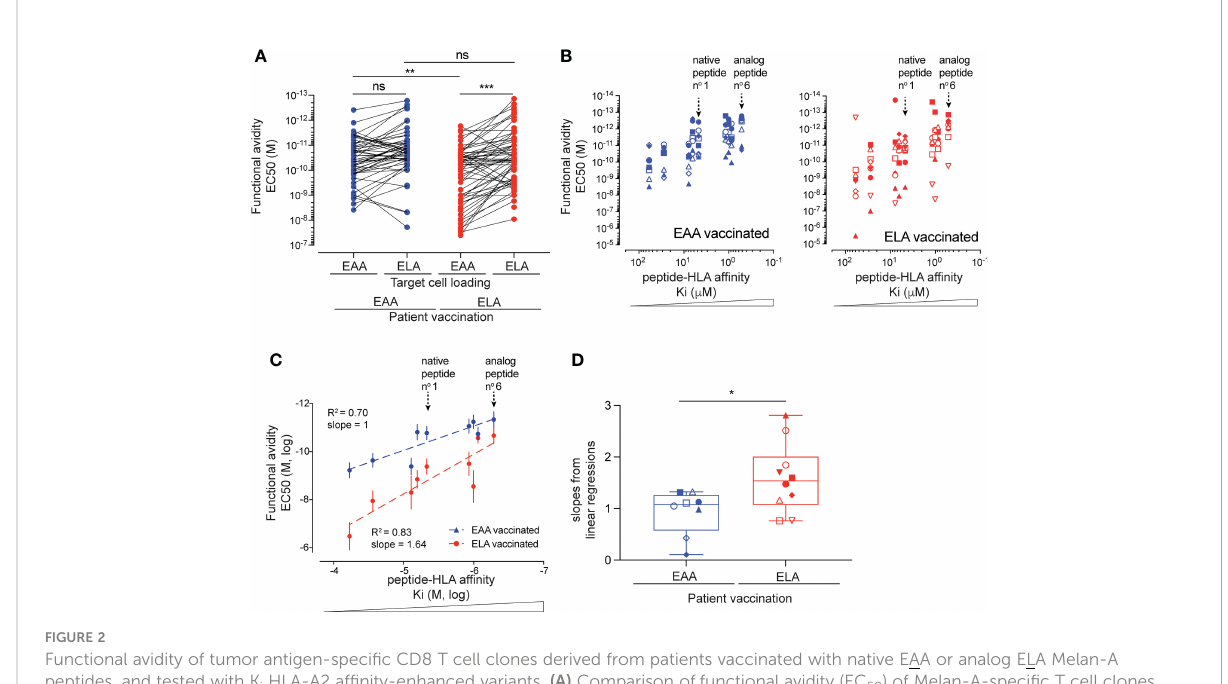
FIGURE 2 Functional avidity of tumor antigen-speci fi c CD8 T cell clones derived from patients vaccinated with native EAA or analog ELA Melan-A peptides, and tested with K i HLA-A2 af fi nity-enhanced variants. (A) Comparison of functional avidity (EC 50 ) of Melan-A-speci fi c T cell clones obtained from patients vaccinated with native EAA (n=31) or analog ELA (n=26) peptide and tested in criss-cross experiments against native (EAA) and analog (ELA)-pulsed targets. (B) Association analysis between functional EC 50 avidity of T cells isolated from EAA (left, n=8) or ELA (n=10) vaccinated patients and K i af fi nity values of the target peptide variants. Symbols represent individual T cells clones isolated from four (EAA vaccine), respective fi ve (ELA vaccine) treated melanoma patients. (C) Correlation analysis for both EAA (blue) or ELA (red) vaccinated patients between the mean EC 50 values obtained from T cell killing assays against a given target variant and the K i af fi nity values of the respective peptide variants (n = 8 to 10). Average R square and slopes of the linear best fi t regression line are given. Native peptide n°1 and analog peptide n°6 are indicated. (D) Comparison of the individual slopes ( D Y/ D X) obtained from the linear best fi t regression lines of the distinct EAA and ELA vaccine-derived T cell clones. Whisker boxes (5 th and 95 th percentile) with individual points, means and error bars are shown. ns p > 0.05 and *p ≤ 0.05, **p ≤ 0.01, ***p ≤